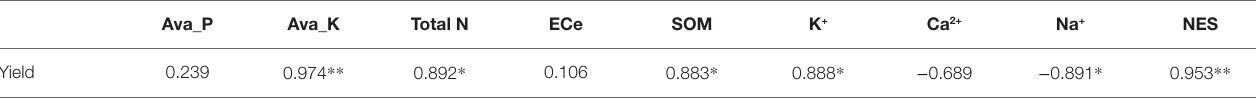
TABLE 4 | Pearson correlations coefficients between alfalfa yield and soil and plant properties ( n = 4) under two seeding pattern treatments.